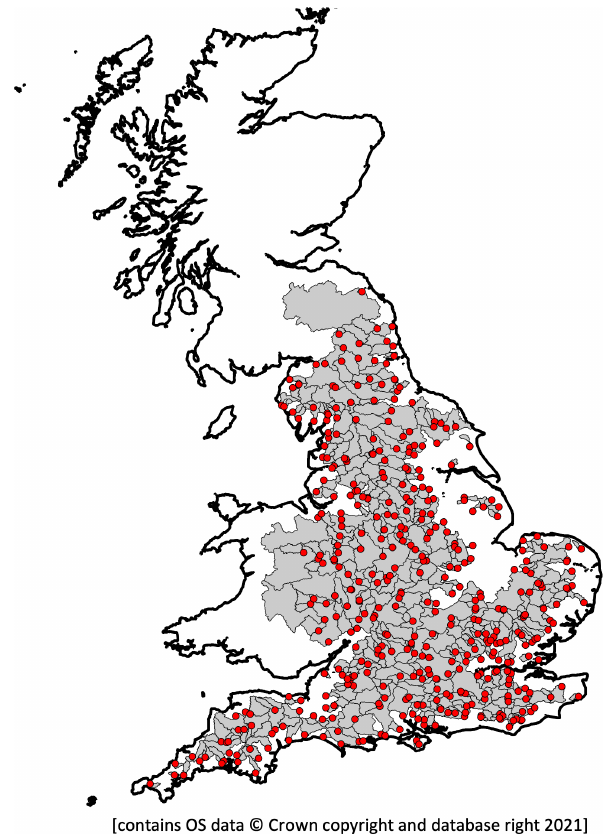
Figure 1. Location of catchments in the study area.